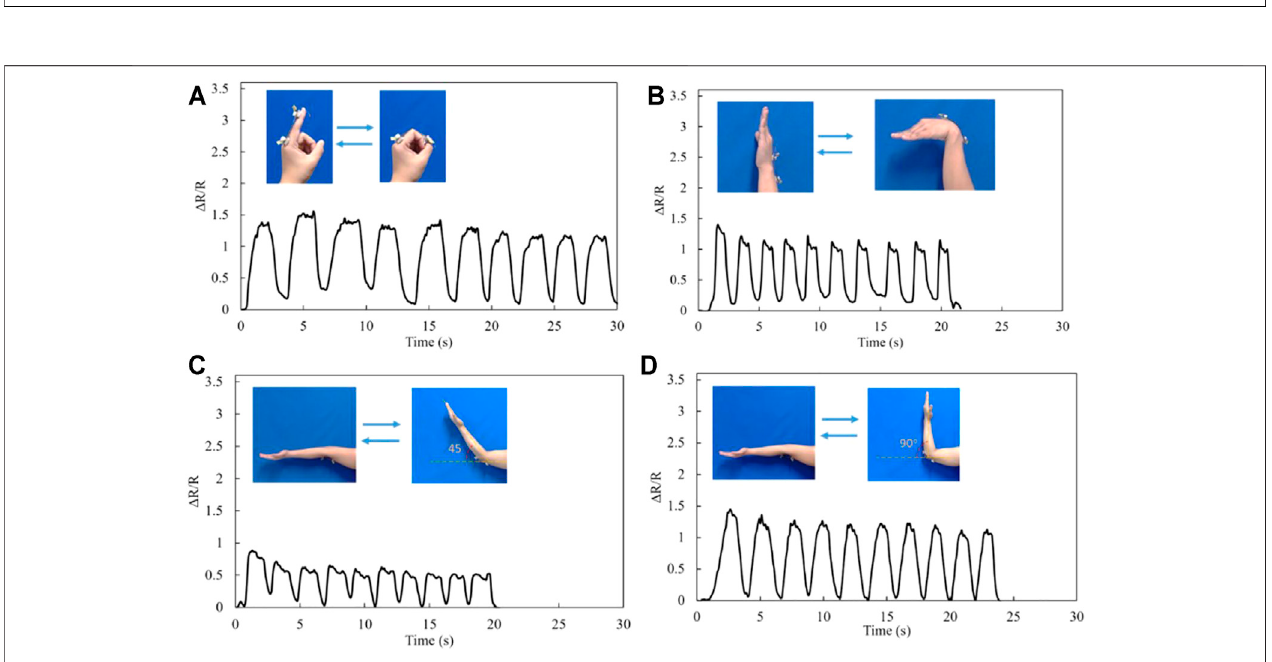
FIGURE 13 | Response patterns of the PDMS-PEIE/MWCNTs-1 sensor fi xed on (A) index fi nger, (B) wrist, (C) 45-degree movement of the elbow, and (D) 90- degree movement of the elbow.